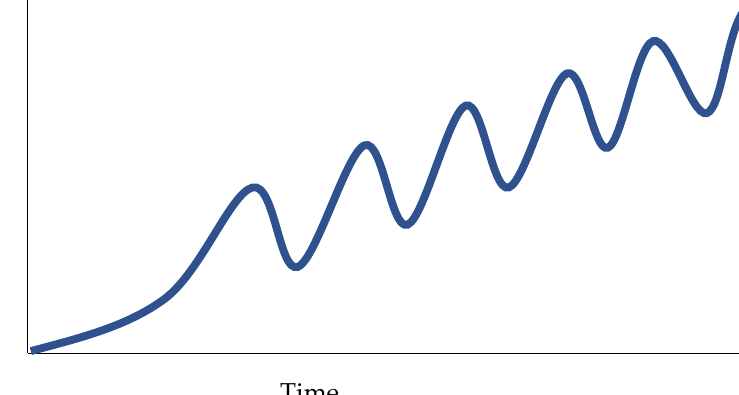
Figure 2. Oscillating pattern of BRD morbidity observed with short-term solutions.